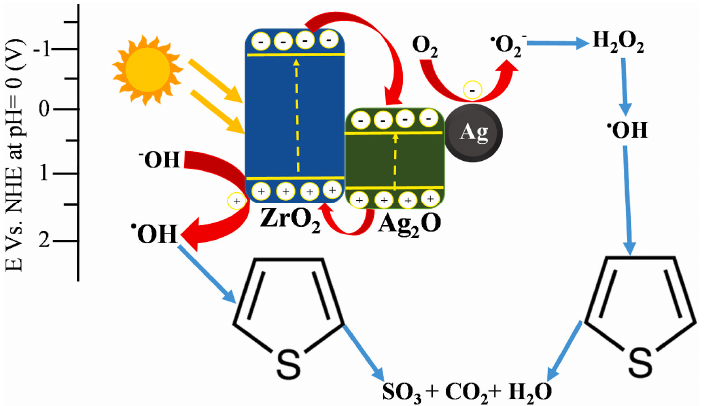
Figure 7. Mechanism of the photocatalytic desulfurization over the Ag 2 O/ZrO 2 photocatalyst. Reproduced from ref. [97] with permission from Elsevier. Copyright 2022 Elsevier.